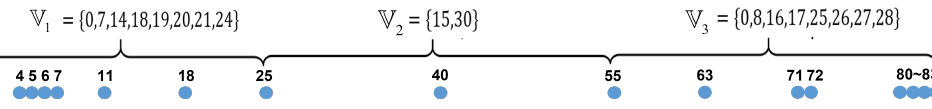
Figure 3. TS-ENA configuration with R = 17, M = 2, N = 15. The black numbers are the position of elements in the physical